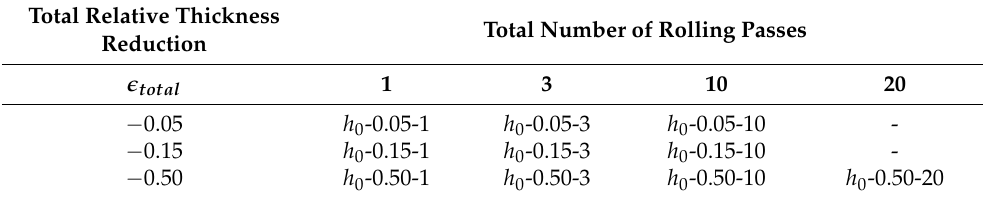
Table 1. Sample labels according to test parameters with starting thickness h 0 = 5mm ∨ 20mm. Total Relative